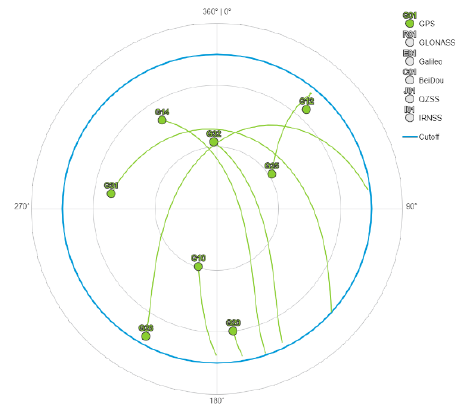
Figure 23. Skyplot from Trimble GNSS planning online Yet, after analyzing the true 3D terrain data, this experiment showed the true mask angle should resemble that in Figure 16. Hence, after combining satellite position and mask angle, the corrected skyplot was generated, with the number of visible satellites 3 instead of 8 (Figure 24).